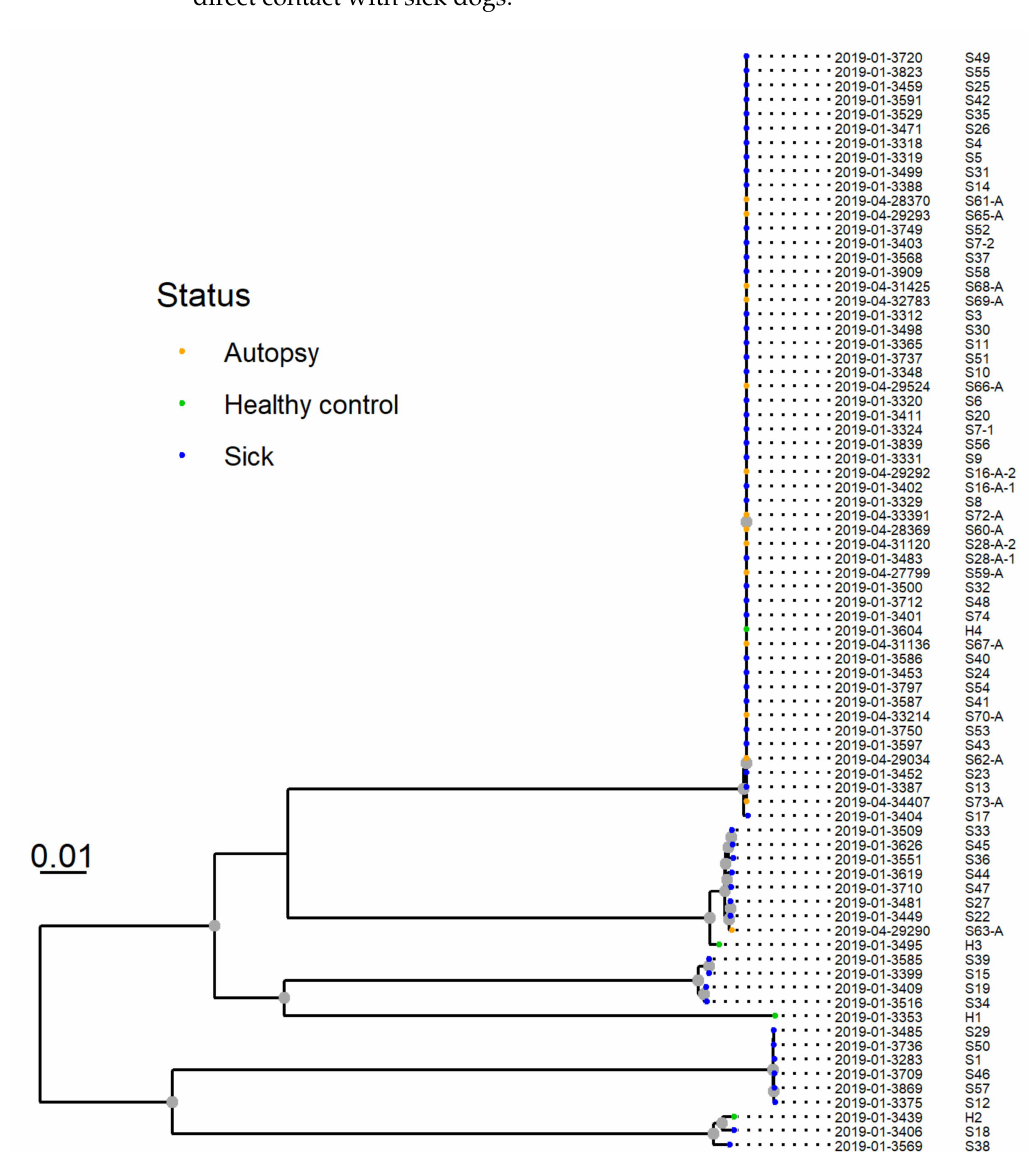
Figure 7. SNP-based phylogeny of whole genome sequences from 77 Providencia alcalifaciens isolates from 75 dogs. P. alcalifa- ciens from sick and diseased dogs ( n = 53), including one isolate from a healthy dog, clustered closely together. This cluster was designated “clone A”, and shared 81.1% of their genomes and had six or fewer SNP